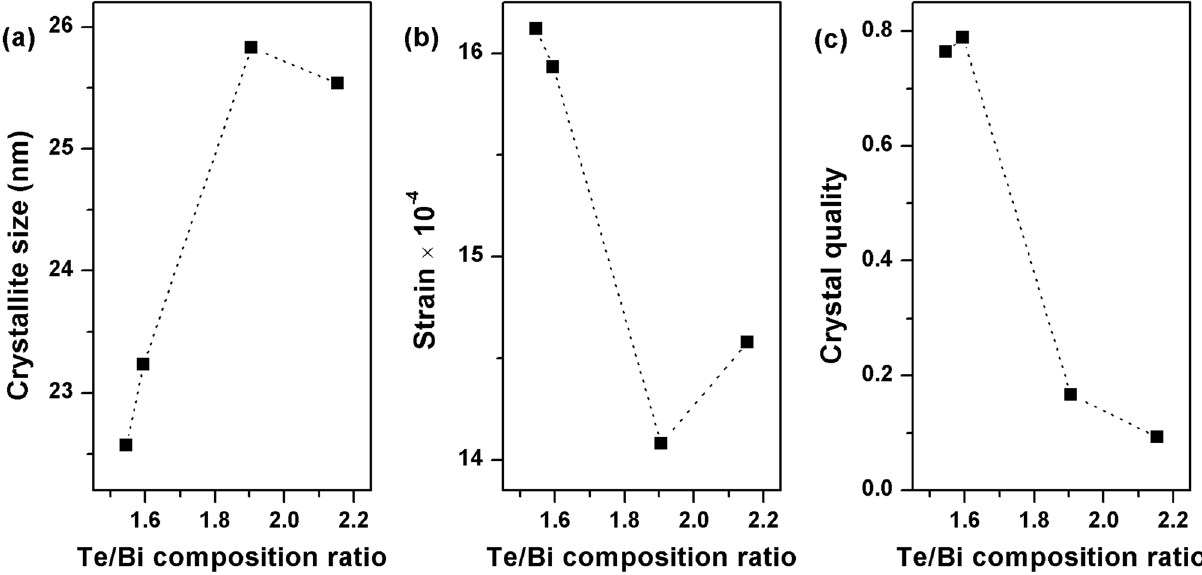
Figure 8. The average crystallite size, lattice strain and crystal orientation/quality of the annealed Bi–Te thin films.